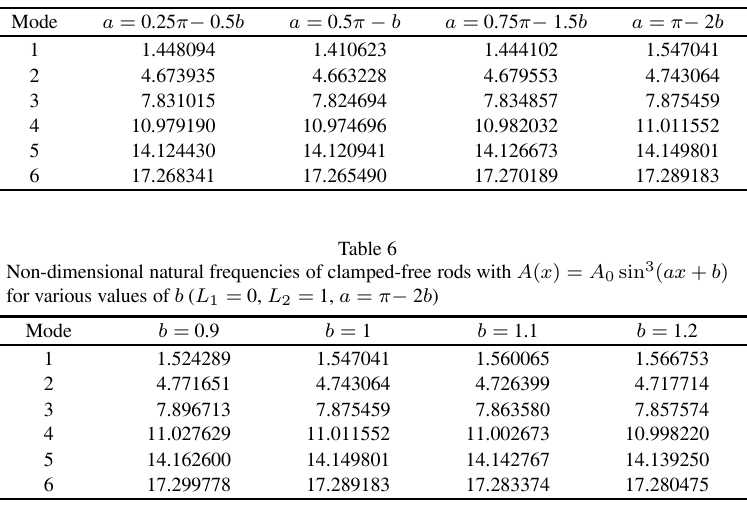
Table 7 Non-dimensional natural frequencies of clamped-free rods with A ( x ) = A 0 sin n ( ax + b )